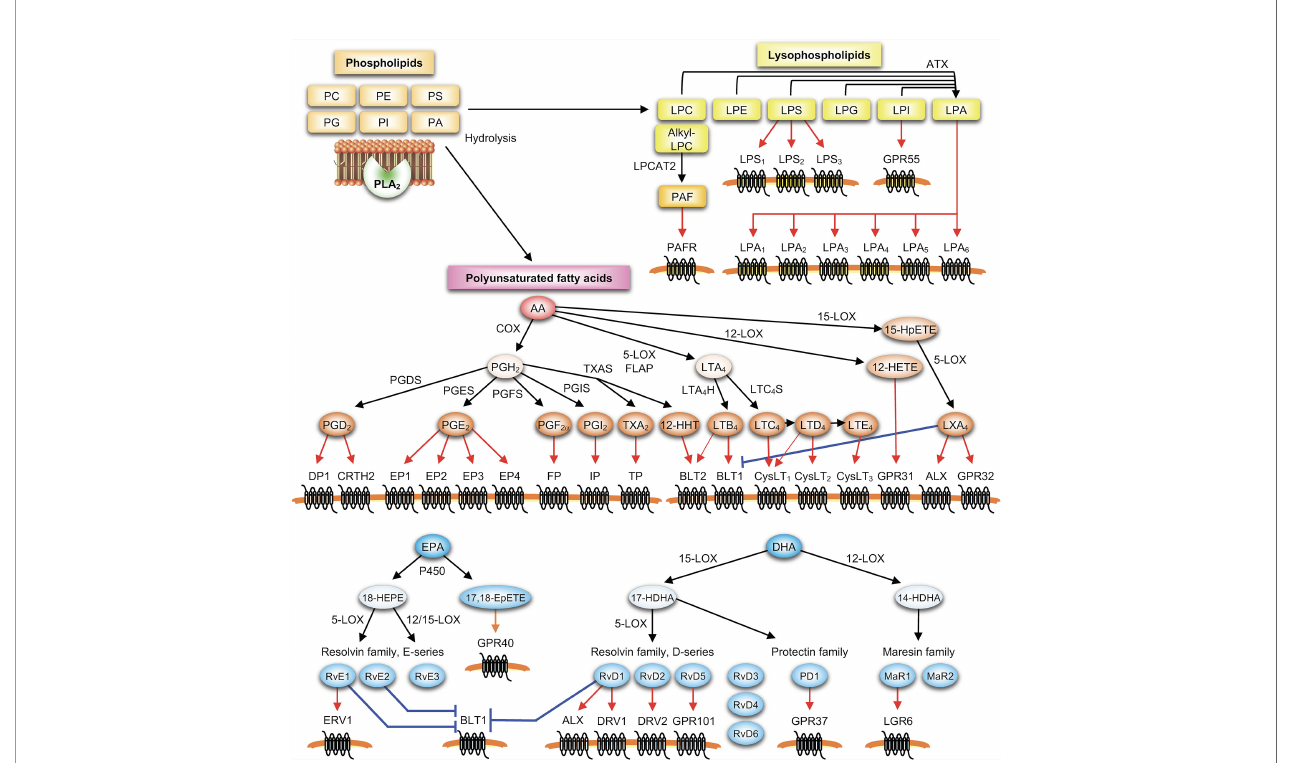
FIGURE 1 | PLA 2 -driven lipid mediator pathways. Lysophospholipids (such as lysophosphatidylcholine (LPC), lysophosphatidylethanolamine (LPE), lysophosphatidylserine (LPS), lysophosphatidylglycerol (LPG), lysophosphatidylinositol (LPI) and LPA) and polyunsaturated fatty acids (such as AA, EPA and DHA) released from membrane phospholipids (PC, PE, PS, phosphatidylinositol (PI), phosphatidylglycerol (PG) and phosphatidic acid (PA)) by PLA 2 are metabolized by downstream enzymes into various lipid mediators, which in turn act on their speci fi c receptors on target cells. In the PLA 2 -lysophospholipid axis, various lysophospholipids are converted by autotaxin (ATX) into LPA, and alkyl-LPC is converted by LPC acyltransferase 2 (LPCAT2) into PAF. In the PLA 2 -PUFA axis, w 6 AA released by PLA 2 is metabolized into prostanoids including PGD 2 , PGE 2 , PGF 2 a , PGI 2 , TXA 2 , and 12-hydroxyheptadecatrenoic acid (12-HHT) via the COX pathway involving COX-1 or COX-2 and terminal PG synthases (PGDS, PGES, PGF 2 a synthase (PGFS), PGI 2 synthase (PGIS) and TXA 2 synthase (TXAS)), or